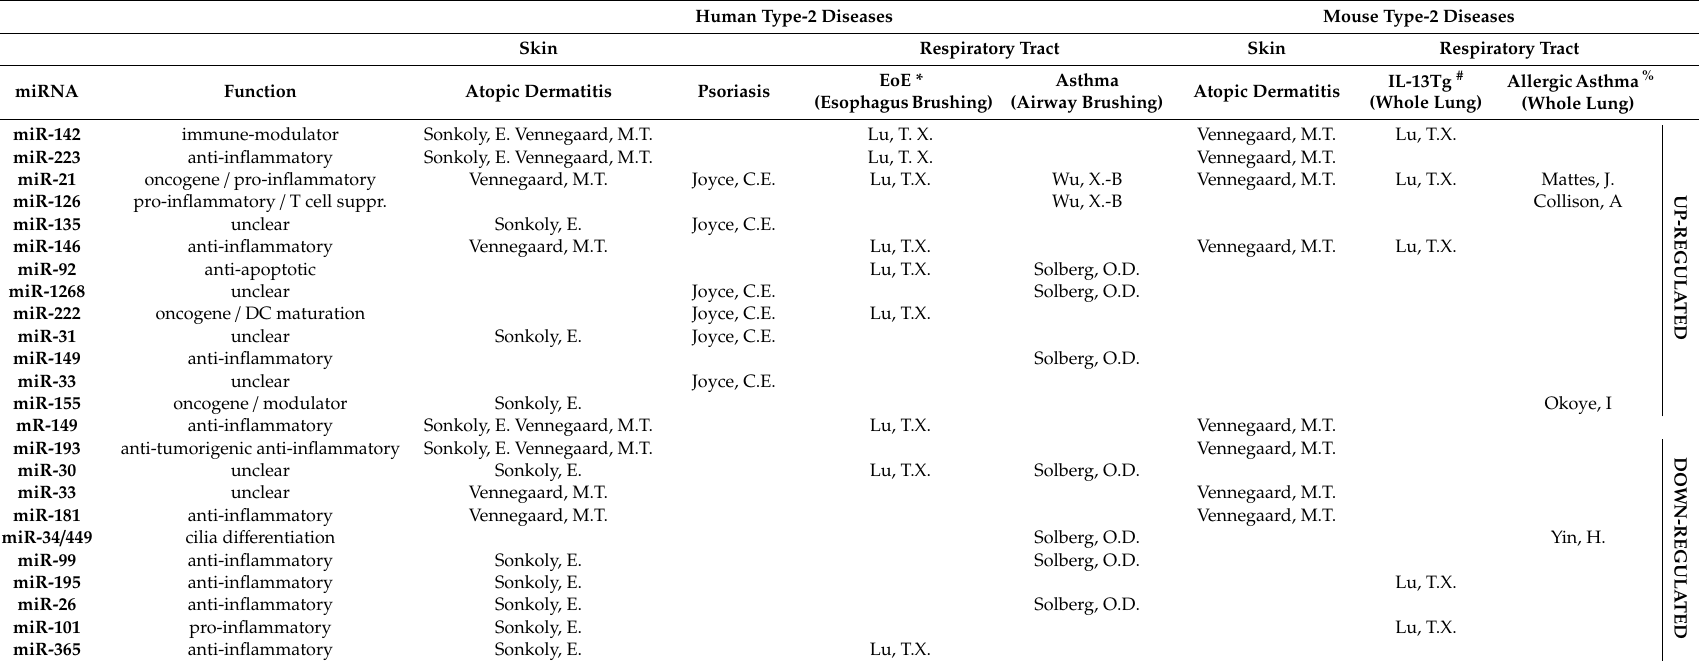
Table 1. miRNAs di ff erentially regulated in type-2 disease. List of up-regulated (top) and downregulated (bottom) microRNAs found in human and mouse tissues in di ff erent type-2 diseases. Data are reported from independent investigators who looked at a panel of miRNAs in an unbiased fashion (via microarray, RT-qPCR screening or smallRNA-Seq) and compared healthy to inflamed tissue. The presence of the same miRNAs in both human disease and mice models, or in di ff erent type-2 disease, highlights its role as a ‘type-2-associated